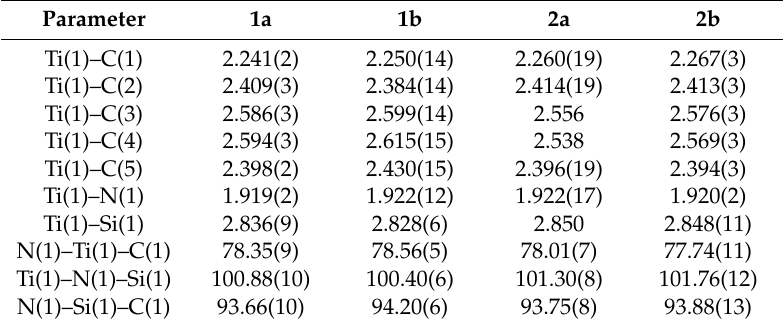
Table 2. Selected bond lengths (Å) and bond angles ( ◦ ) for related complexes. Parameter